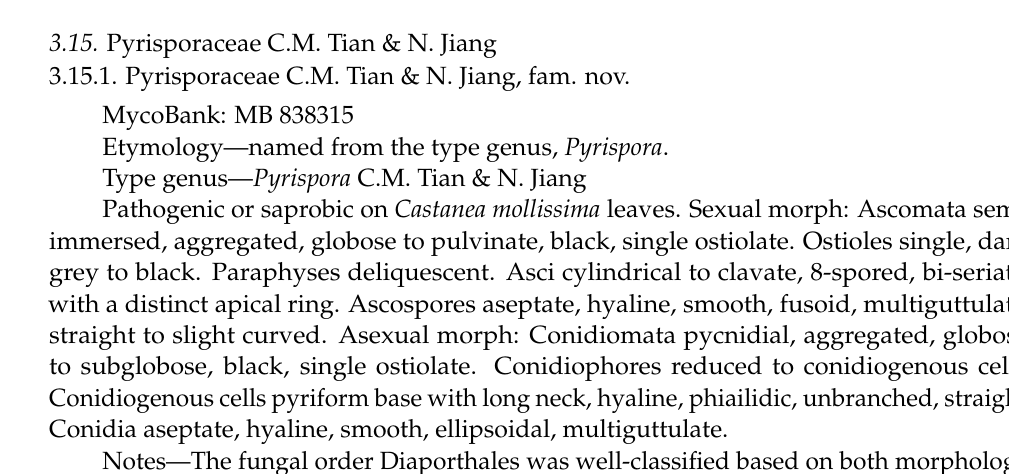
Figure 22. Gnomoniopsis daii (BJFC-S1794). ( A , B ) Conidiomata on the diseased leaves of Castanea mollissima (arrows showing orange tendrils); ( C , D ) Conidiogenous cells giving rise to conidia; ( E , F ) Conidia. Scale bars: ( C – F ) = 10 µ